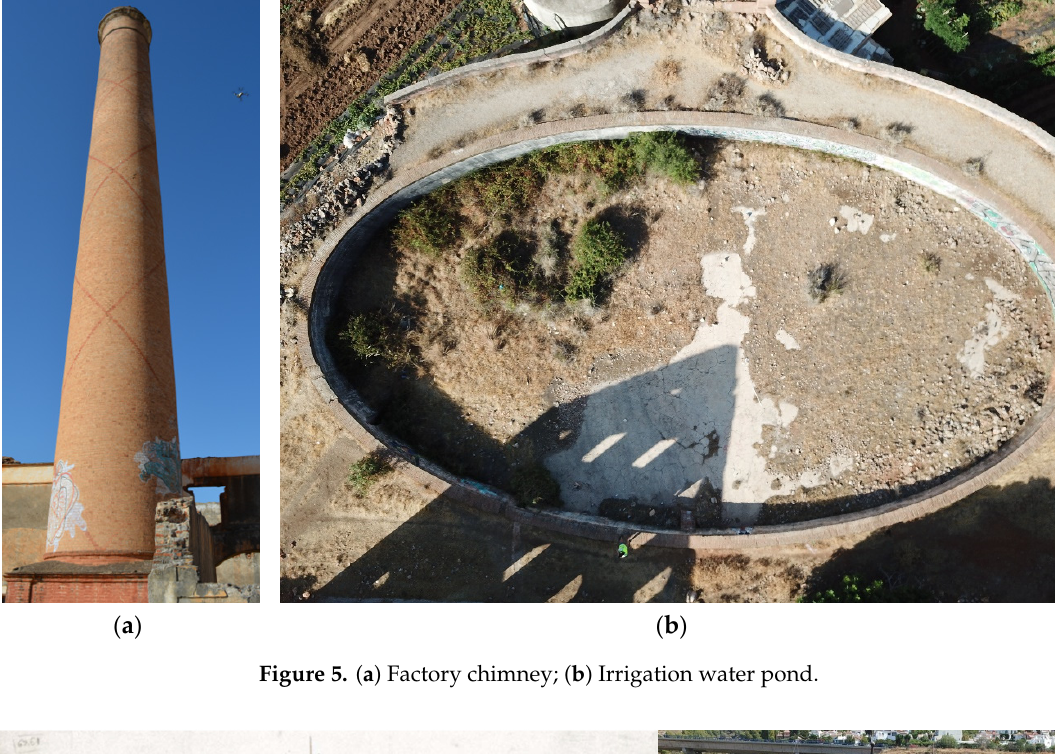
Figure 5. ( a ) Factory chimney; ( b ) Irrigation water pond.